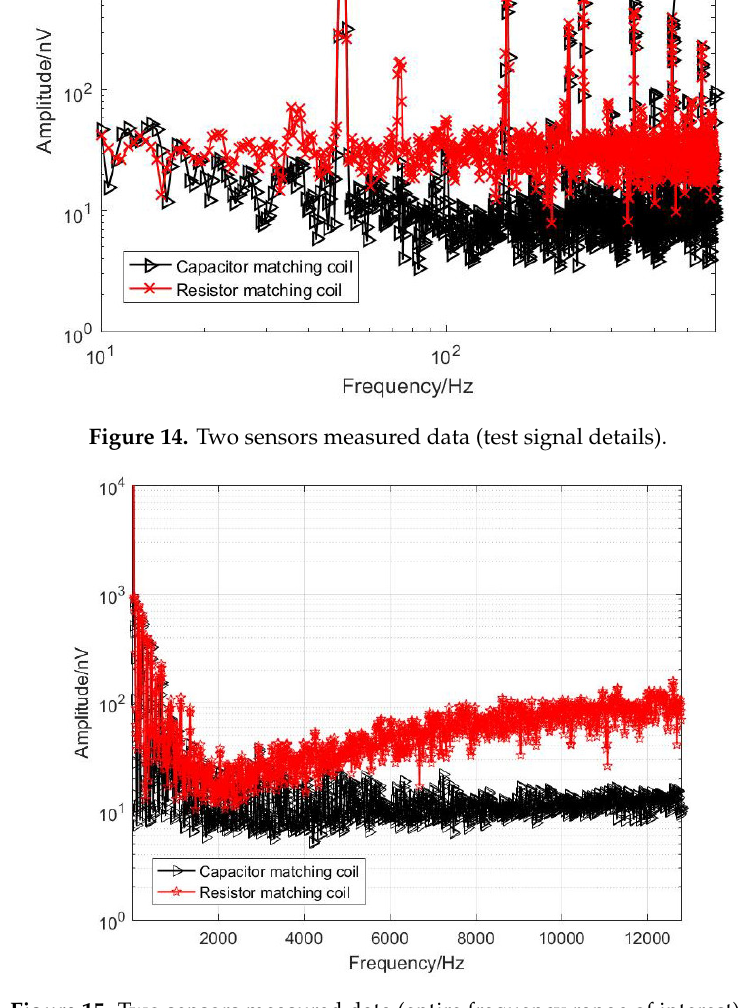
Figure 15. Two sensors measured data (entire frequency range of interest).